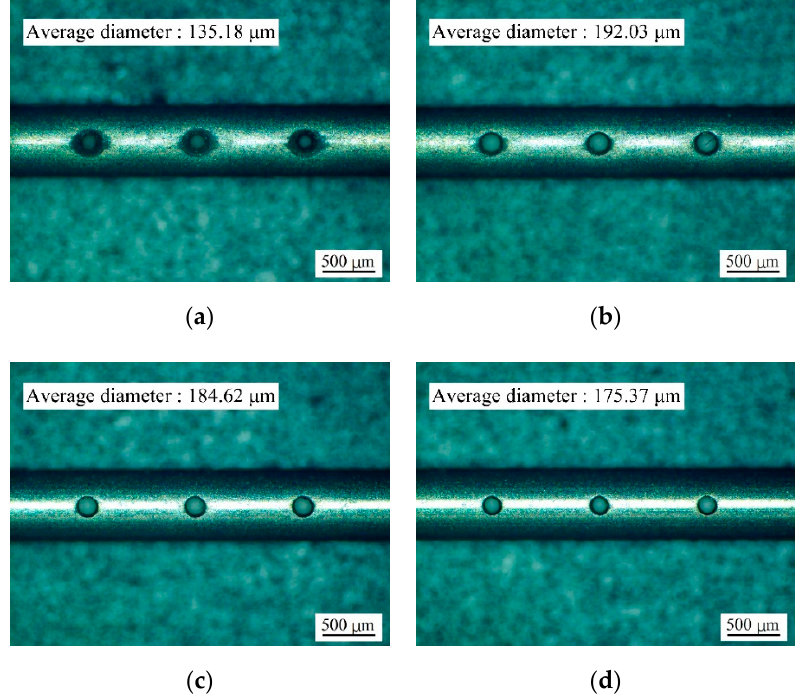
Figure 5. Shape of holes drilled with different frequency: ( a ) 10 kHz; ( b ) 20 kHz; ( c ) 50 kHz; ( d ) 100 kHz.